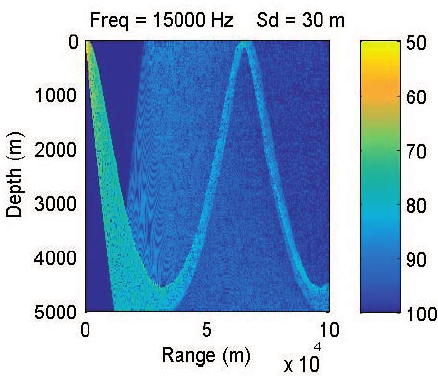
Figure 7. Transmission loss in the selected